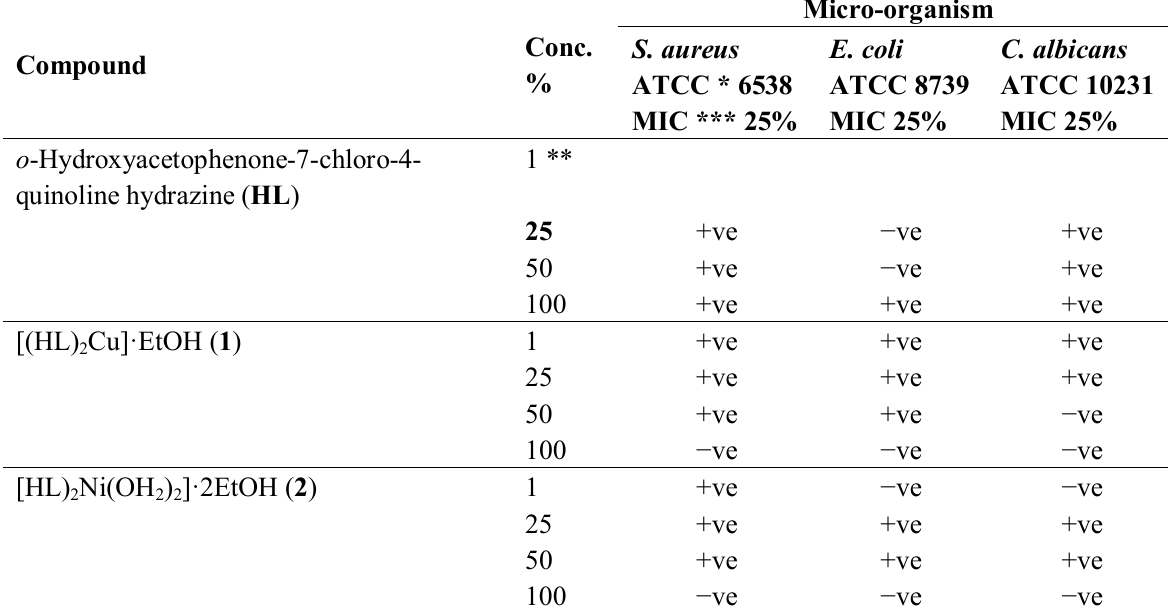
Table 5. Results of anti-microbial activity of some tested